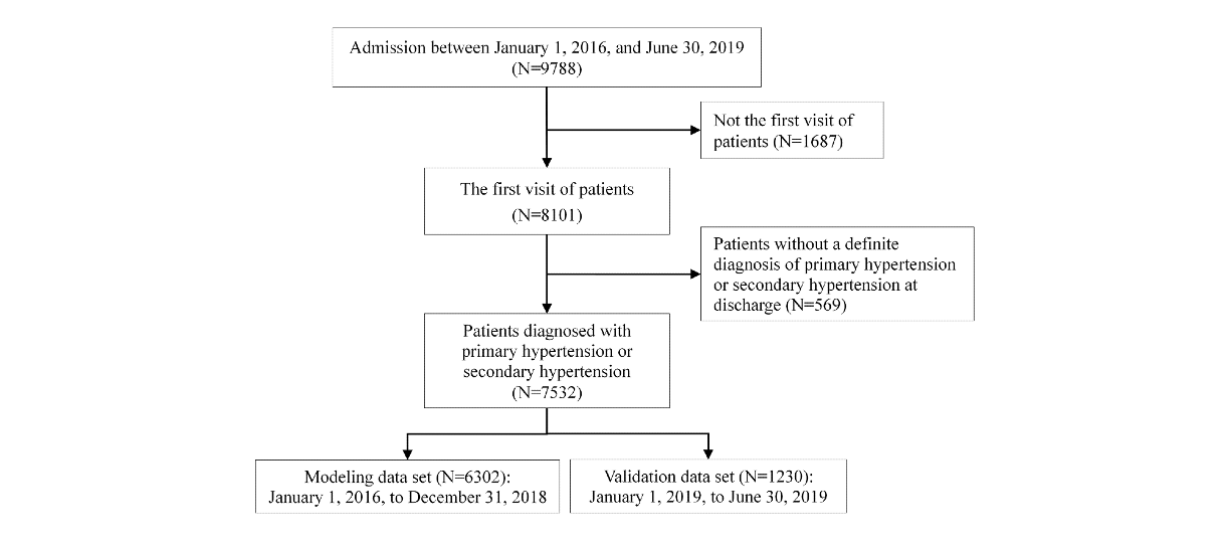
Figure 1. A workflow for patients inclusion and